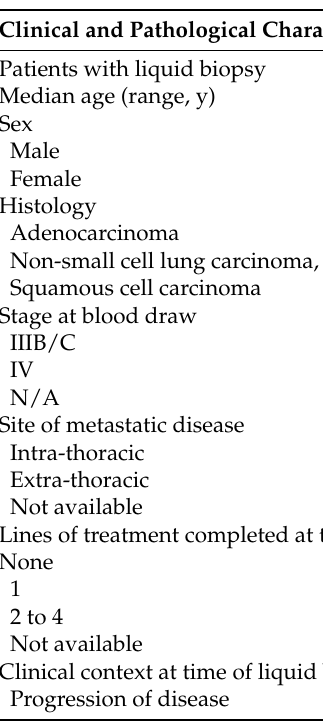
Table 1. Baseline patients’ characteristics and biomarker